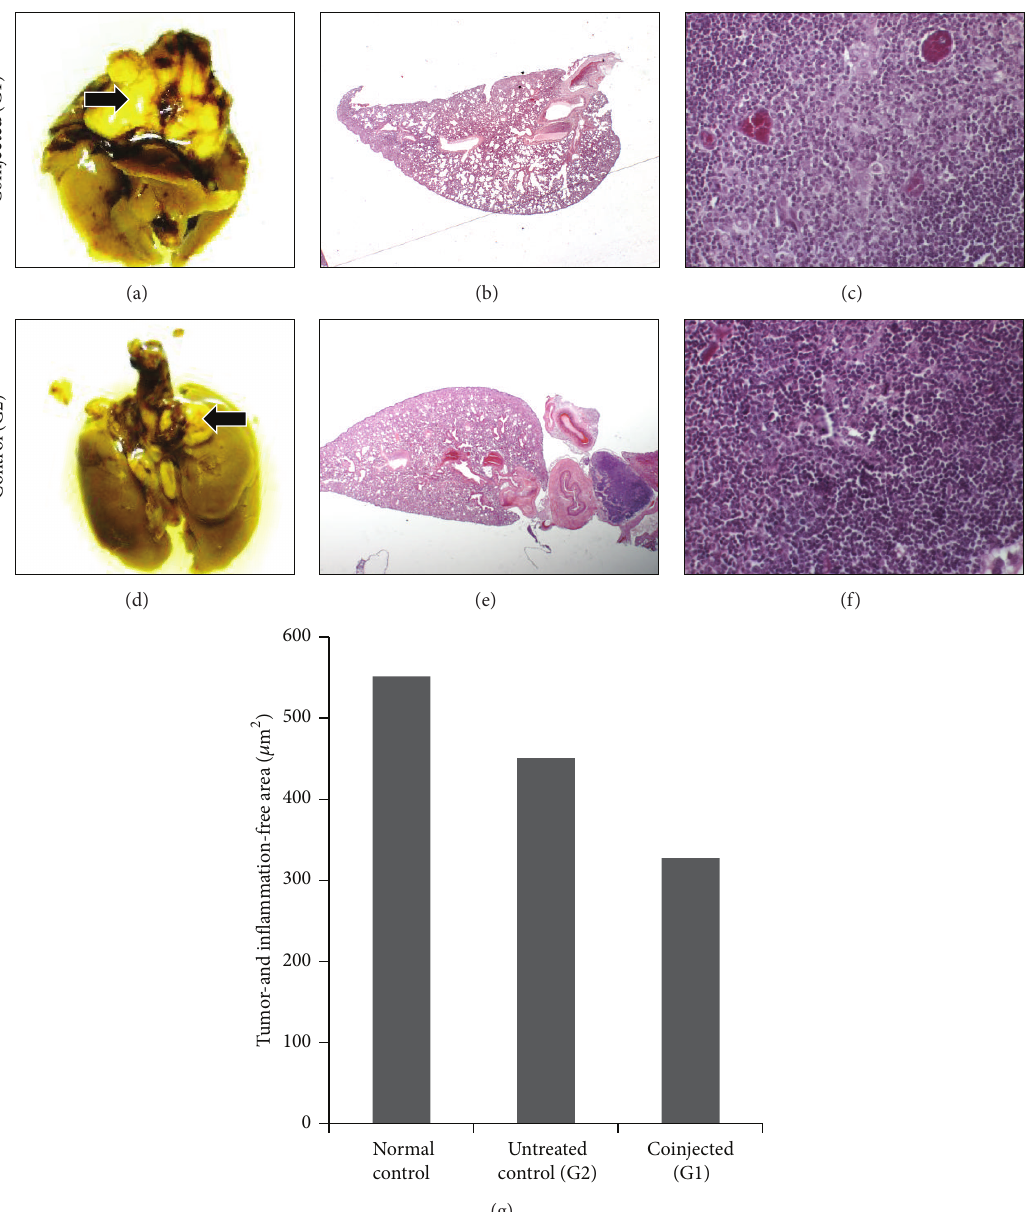
Figure 3: Tumor analysis of G1 and G2 groups. ((a) and (d)) Lungs macroscopic view; ((b) and (e)) lungs microscopic view (2.5x); ((c) and (f)) primary tumors microscopic view (40x). One representative animal of each group is shown. (g) Tissue-free measurement in lungs, showing that coinjected animals presented an increase in inflammation areas in the lungs, despite not having died from respiratory insufficiency. Arrows indicate possible tumor masses near trachea in (a) and